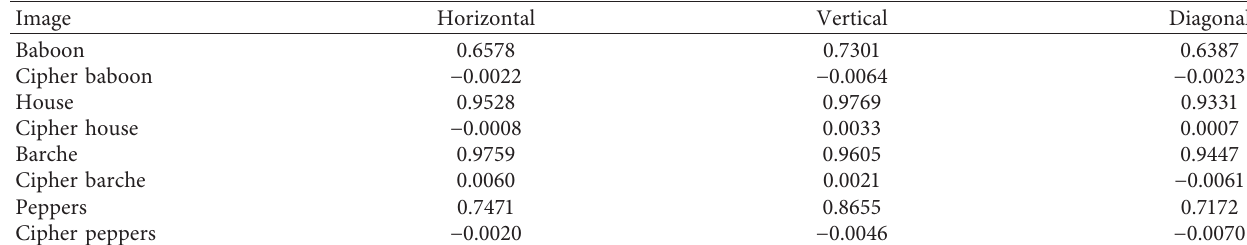
Table 8: Correlation coefficient of images.